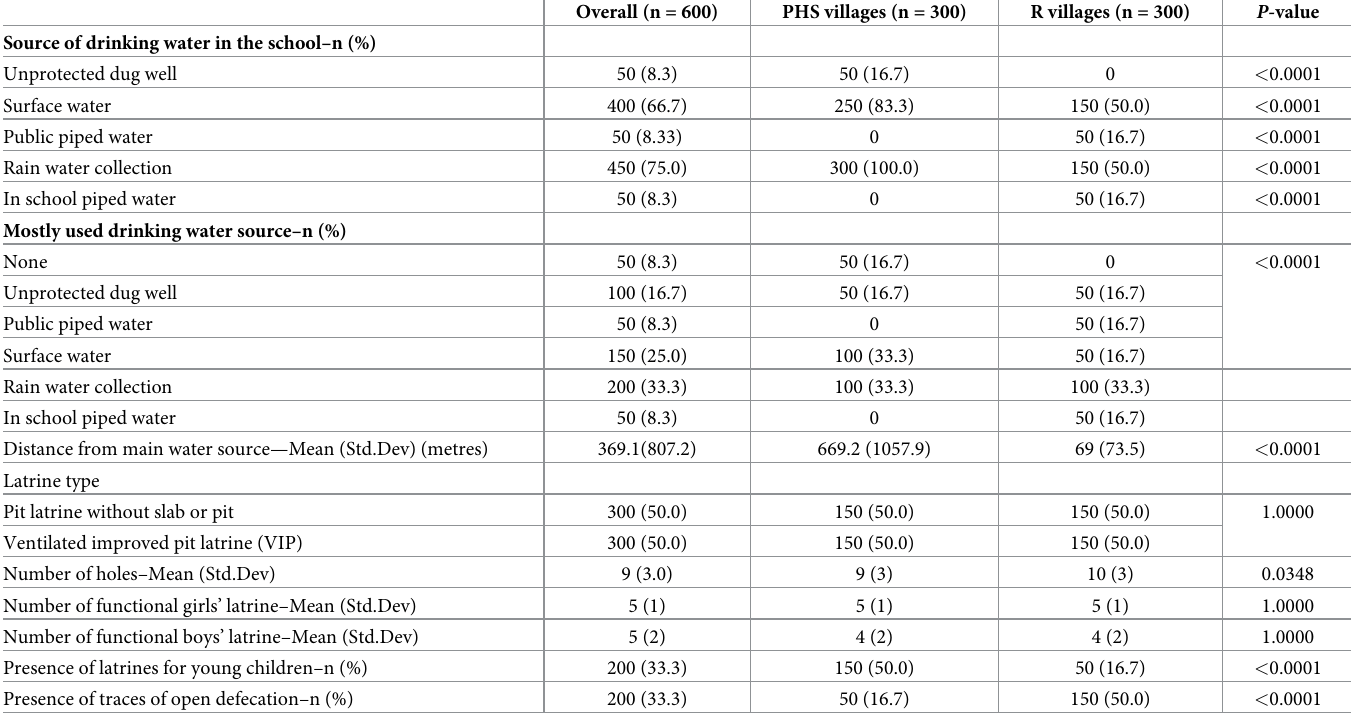
Table 8. Descriptive statistics on water, sanitation and hygiene in study villages based on data from school heads.